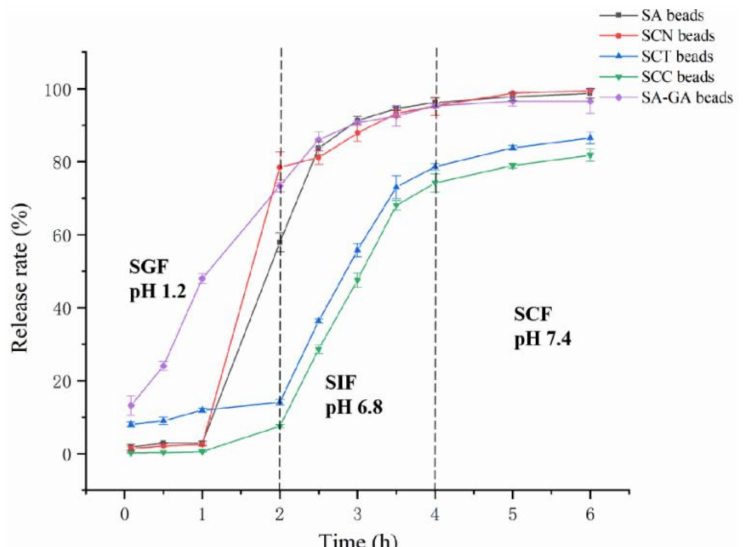
Figure 8. Cumulative release profiles of GA from the beads in SGF (pH 1.2), SIF (pH 6.8), and SCF (pH 7.4). SA, SCN, SCT, and SCC beads were loaded with PG. SA-GA beads were loaded with